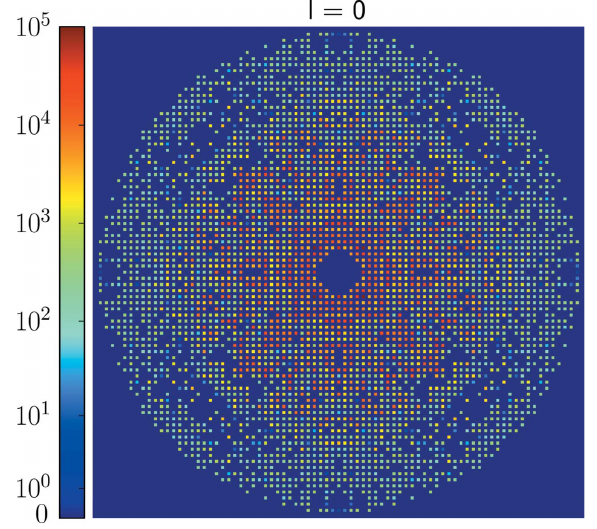
Figure 5 The central slice of the high-resolution three-dimensional intensity model, W , perpendicular to the l axis of the crystal, on the same scale as Fig. 4( a ). Negative reflections were thresholded to zero for rendering.